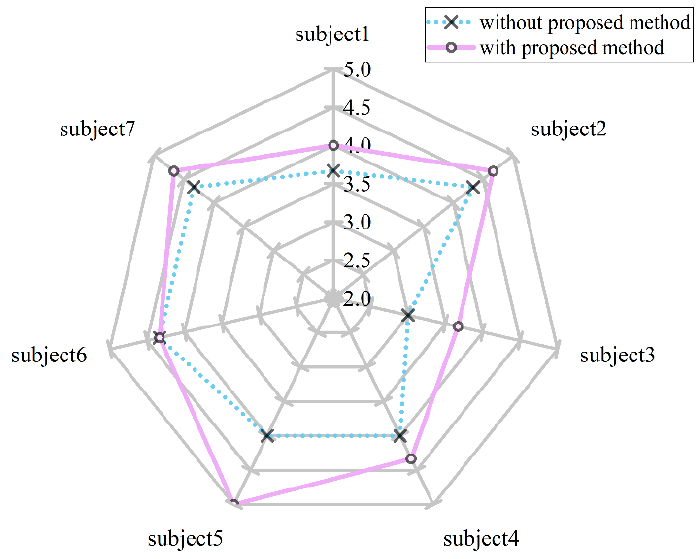
Figure 14. Average user satisfactions with and without proposed method: moving tasks. Table 5. Results of Wilcoxon signed-rank test of user satisfaction based on tasks.